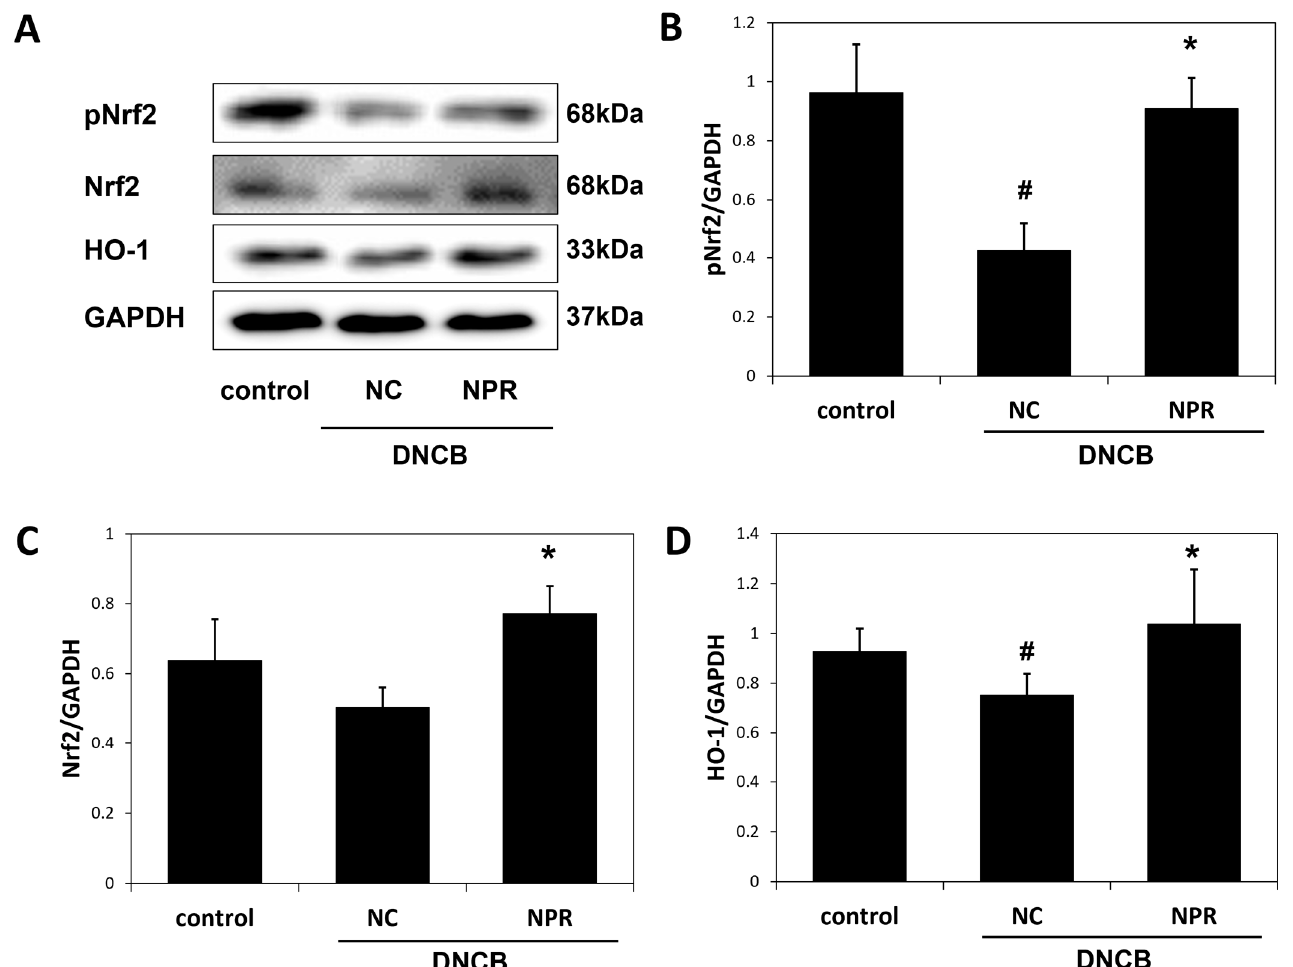
Figure 6. Effects of NPR extract on antioxidant defense enzyme levels. ( A ) pNrf2, Nrf2, and HO-1 protein expressions were analyzed by Western blot. ( B ) pNrf2, ( C ) Nrf2, and ( D ) HO-1 mRNA expressions were analyzed by qPCR. Results are expressed as the means ± SE of 2 to 3 independent experiments. # p < 0.05 vs. untreated control group; * p < 0.05 vs. DNCB-treated mice. control: untreated control group; NC: DNCB-treated negative control group; NPR: DNCB plus N. peltata root extract-treated group.